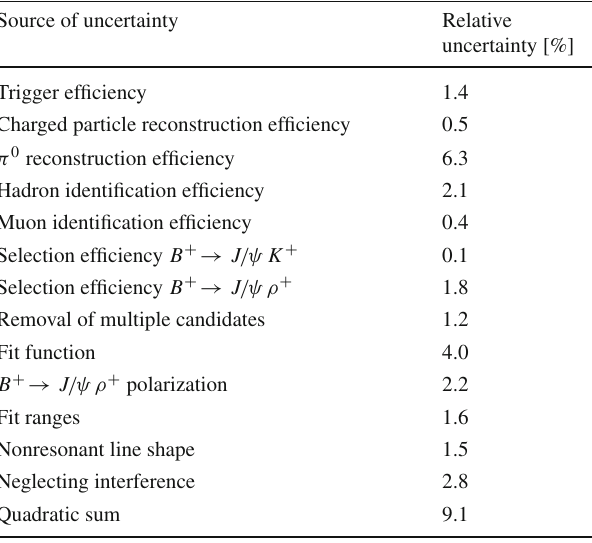
Forthebackgroundcontributionfromthe B + → J /ψ K ∗+ Table 1 Systematic uncertainties on the branching fraction B ( B + → J /ψ ρ +